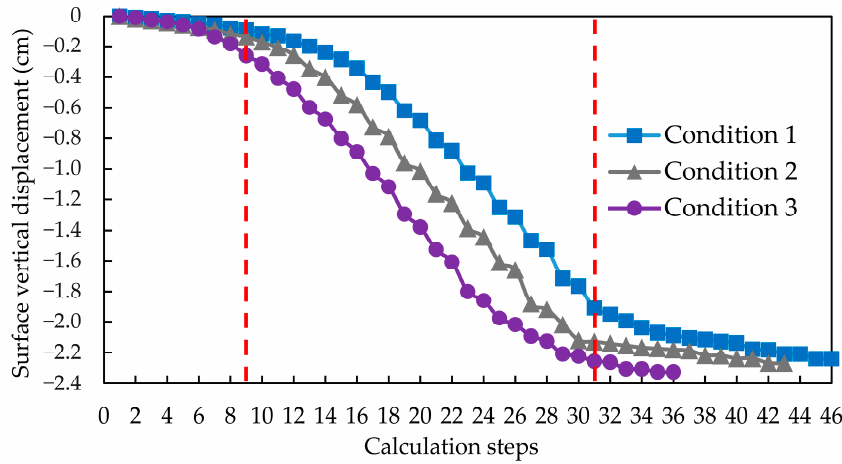
Figure 6. The variation curve of vertical surface displacement of the target section with calculation steps.